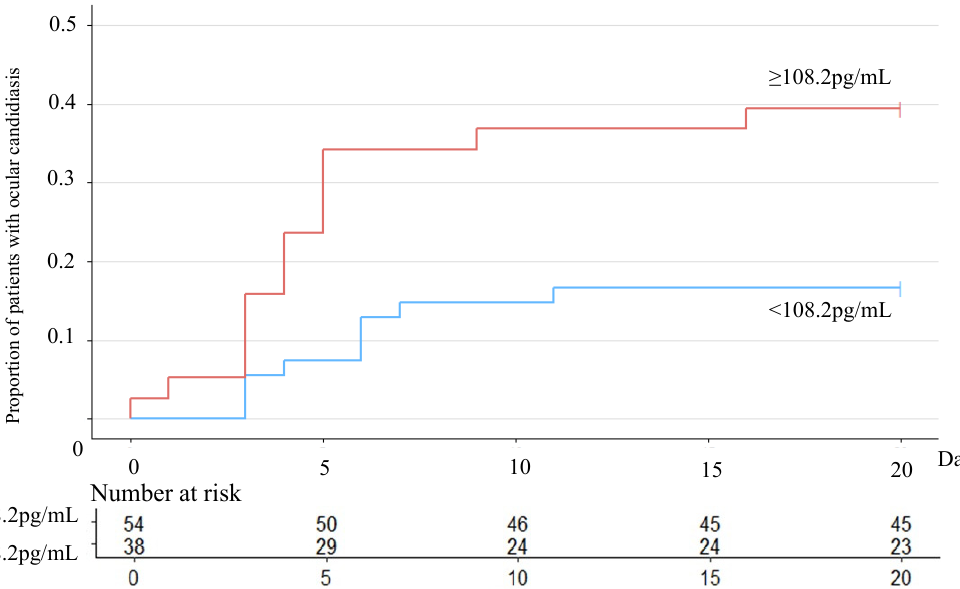
Figure 2. Kaplan − Meier curve showing the proportion of patients with ocular candidiasis in two groups determined by β -D-glucan levels. ROC curves were created for the presence of ocular lesions, and the Youden index was calculated to be 108.2. Based on this β -D-glucan value, cases were divided into two groups. The log-run test was statically significant at p < 0.05.